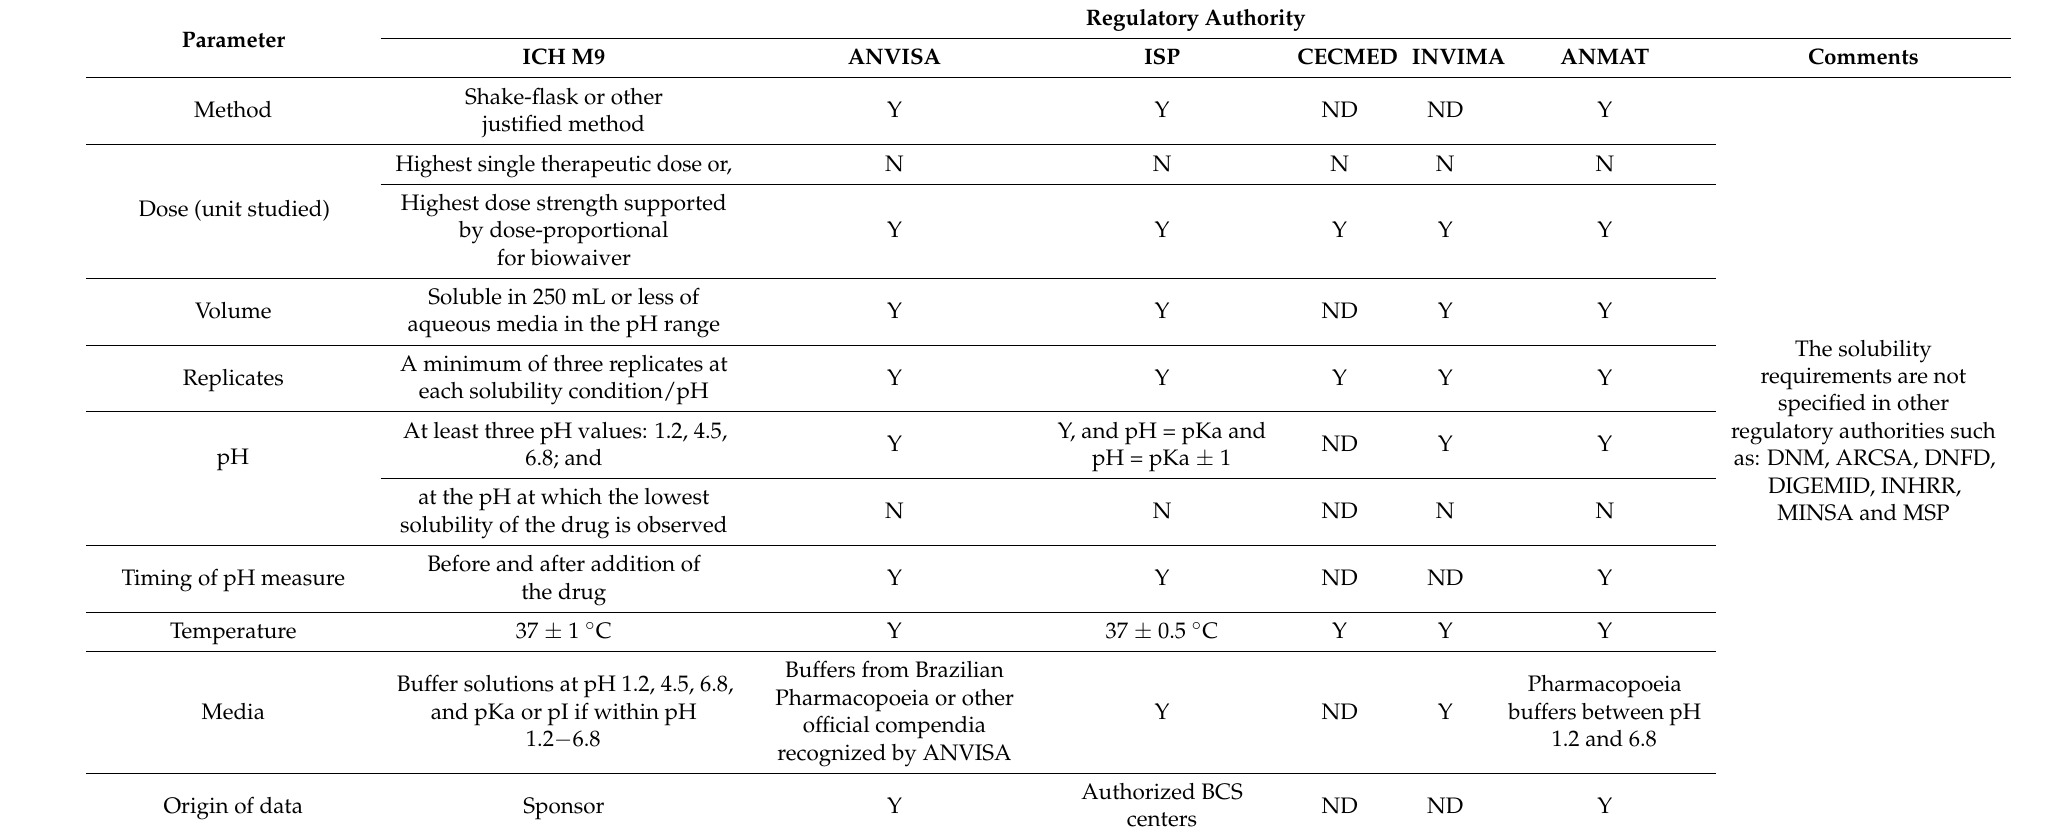
Table 2. Comparison of solubility requirements for BCS-based biowaivers between ICH and Latin American regulatory